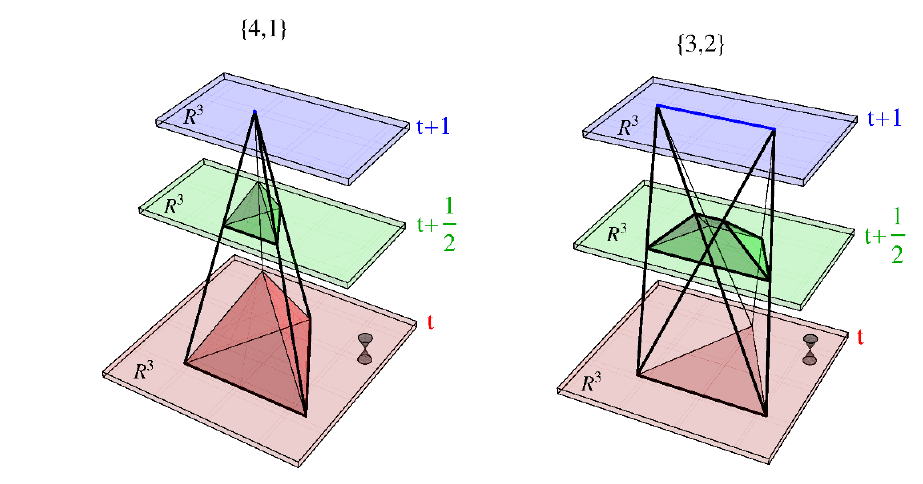
Figure 1 . Visualization of the elementary building blocks of four-dimesnional CDT, the (4 ; 1)- simplex (left) and the (3 ; 2)-simplex